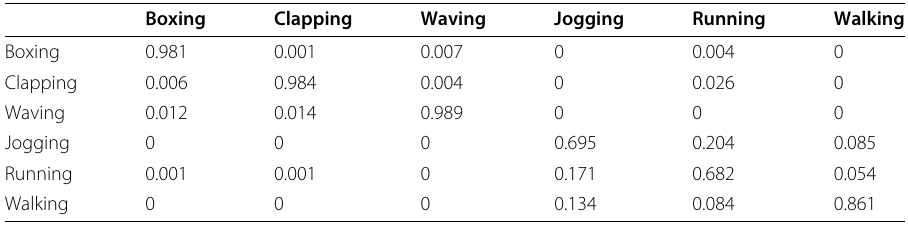
Table 5 ConvLSTM baseline architecture confusion matrix on KTH dataset Boxing Clapping